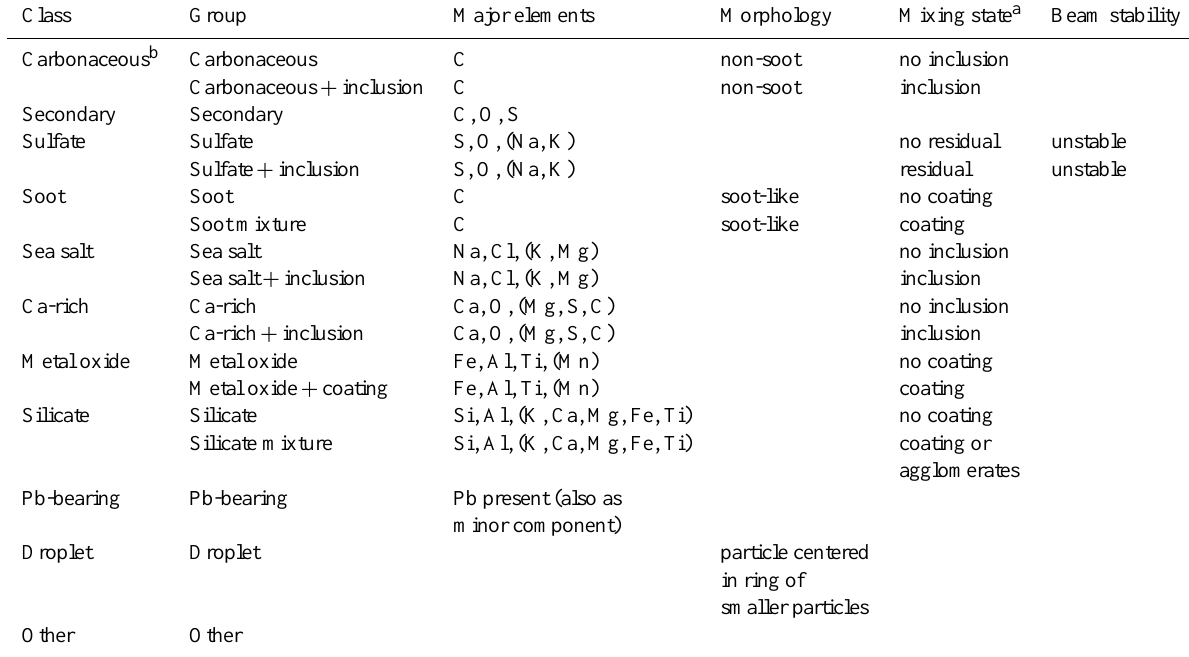
Table 2. Classification criteria for particle classes and particle groups. Common features for certain particle types not used for classification are given in